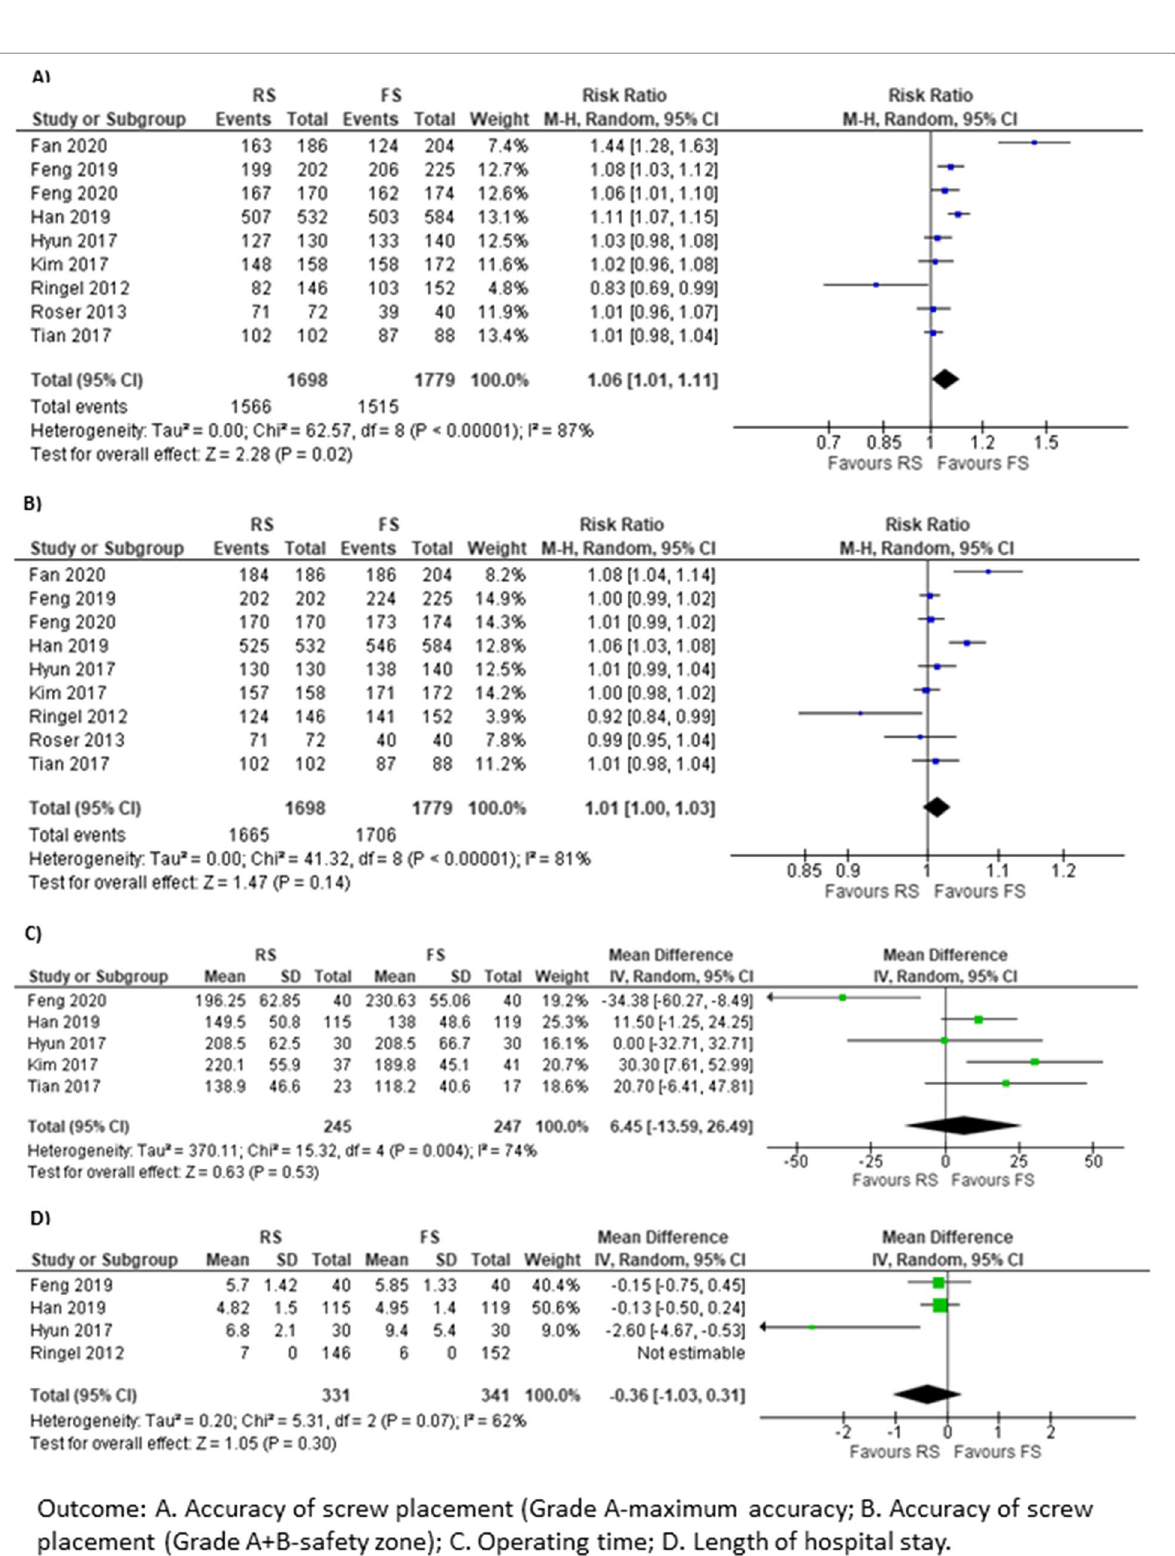
Fig. 3 Results of